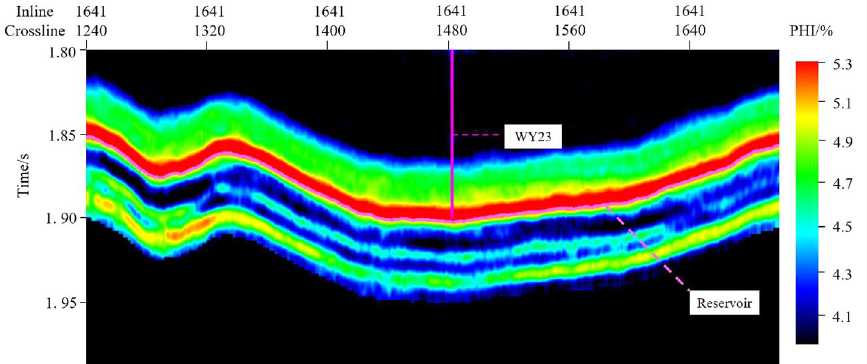
Figure 11. PHI section view of the Longmaxi formation.